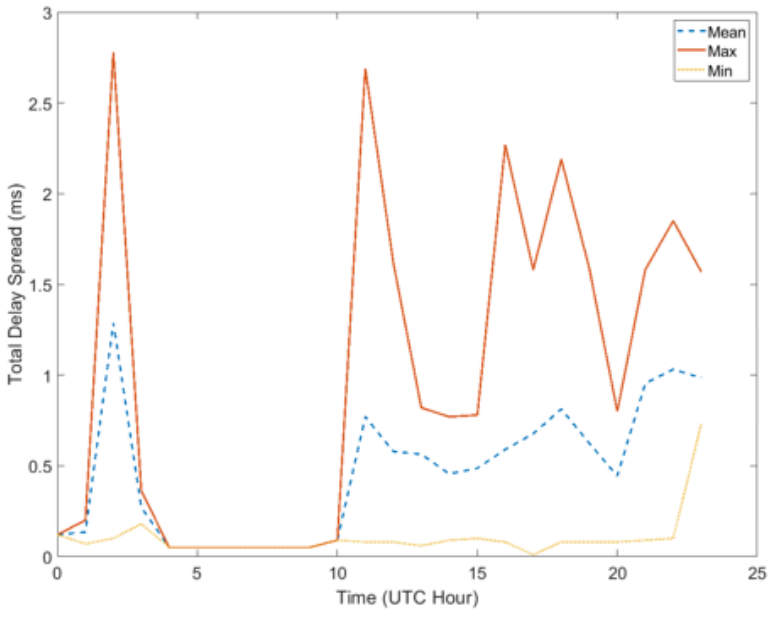
Figure 9. NVIS Total Delay Spread vs. Time.